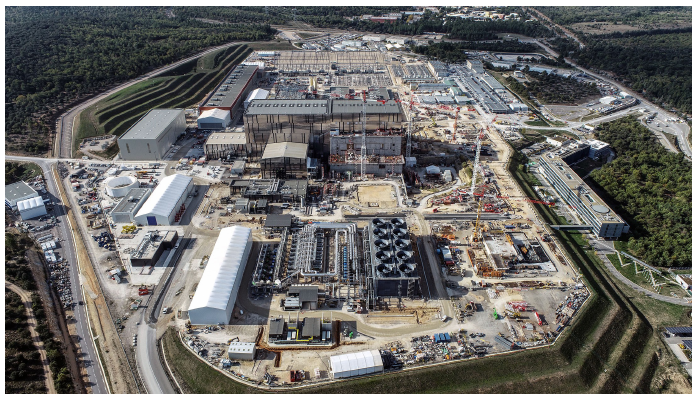
Figure 2. Aerial view of the ITER site. Reprinted from Ref. [5]. Credit c (cid:13) ITER Organization,